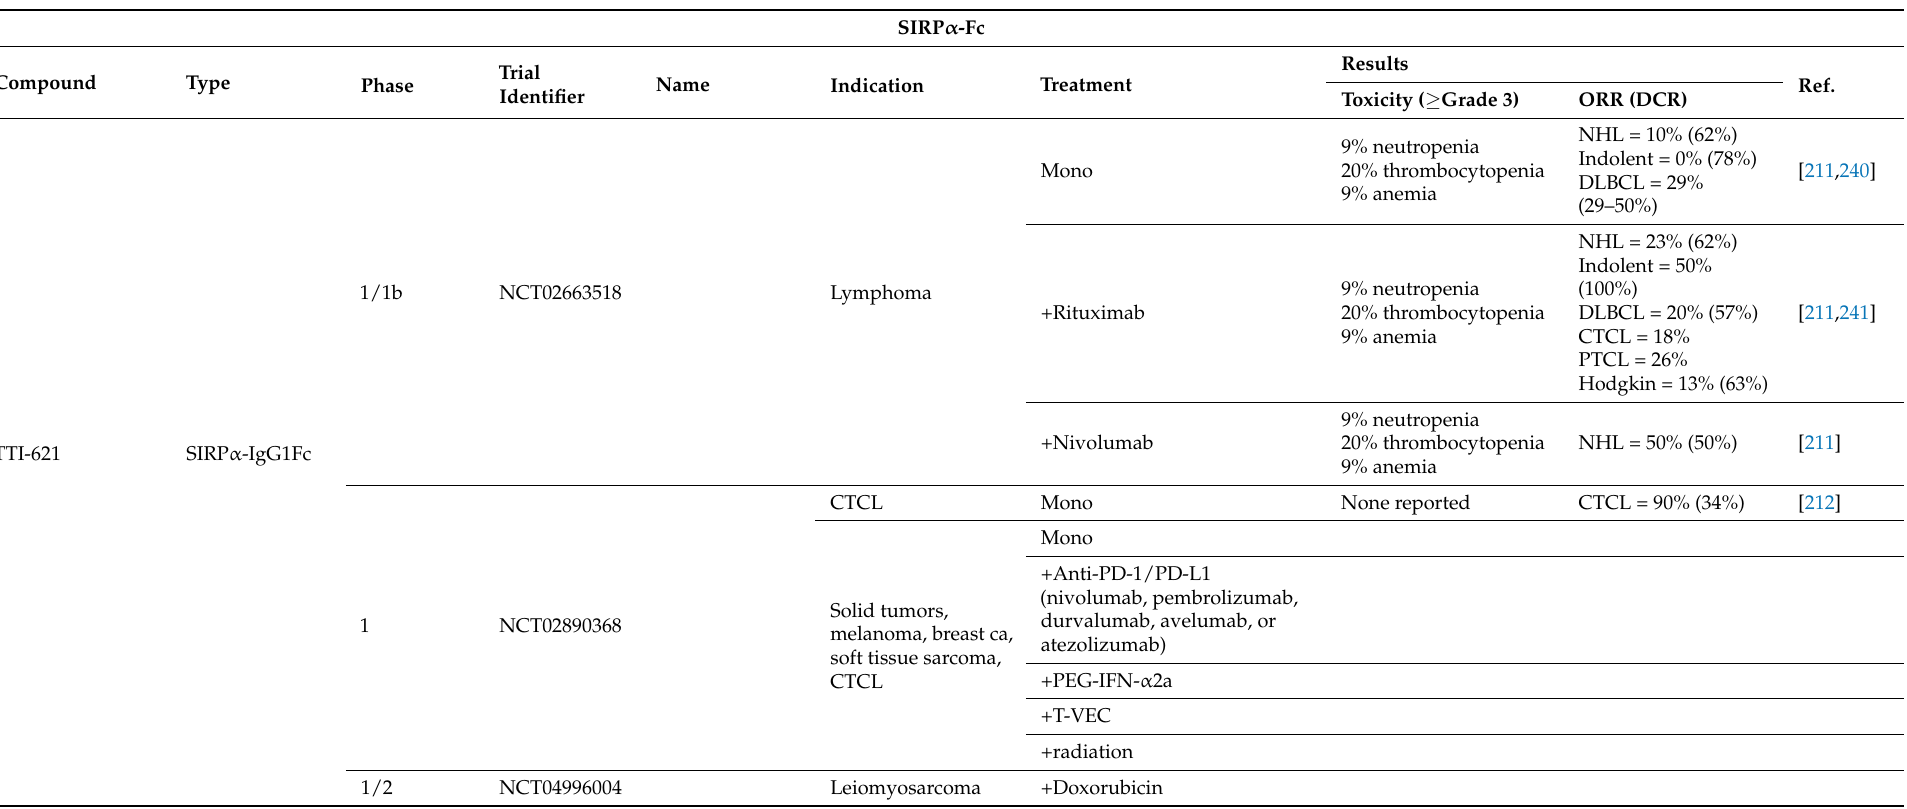
Table 3. SIRP α -Fc fusion proteins investigated in clinical trials. Currently, 9 SIRP α -Fc compounds are investigated in 22 clinical trials, as mono- or combination therapy for various indications. Table updated until 7 April